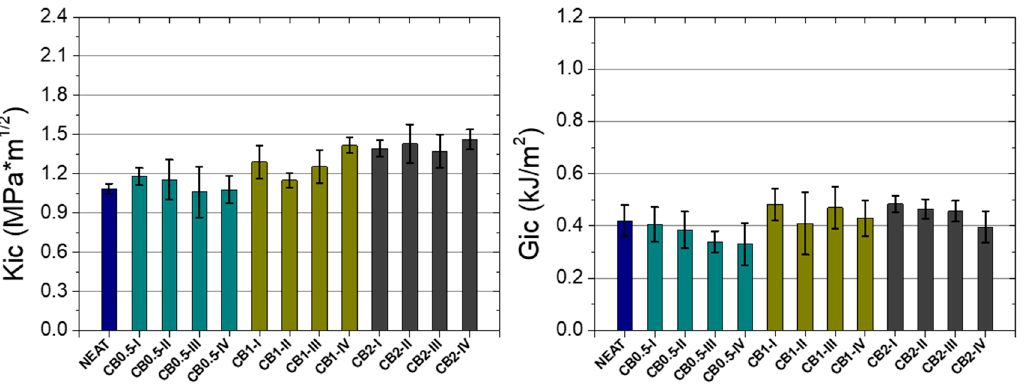
Figure 4. K ic and G ic mean values for specimens with CB.